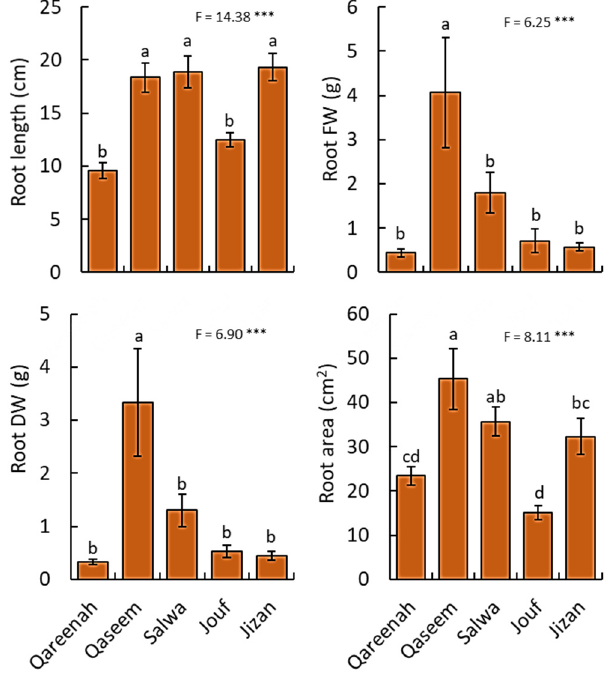
Figure 3. Measured root traits for Aeluropus lagopoides growing in different saline flat regions of Saudi Arabia. Values are average ( n = 75 ), and the bar represents the standard error. Different letters among regions showed significant differences at p < 0.05 after Duncan’s test. *** p < 0.001. FW: fresh weight, DW: dry weight.